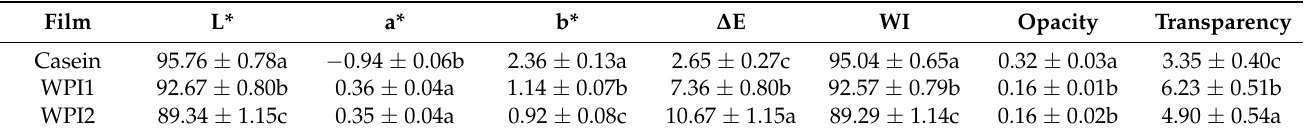
Table 3. Color and optical parameters of milk protein-based edible films 1 .